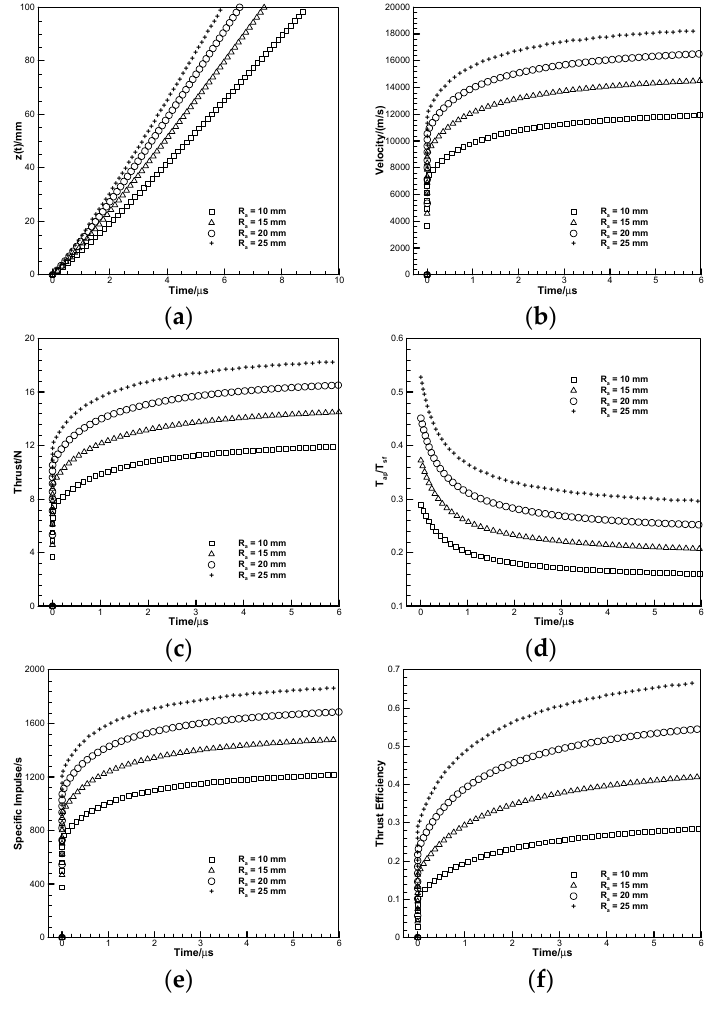
Figure 9. Effects of anode radius on thrust performances: ( a ) Axial movement of current sheet; ( b ) Velocity of current sheet; ( c ) Thrust; ( d ) Ratio of applied-field thrust to self-field thrust; ( e ) Specific impulse; ( f ) Thrust efficiency.